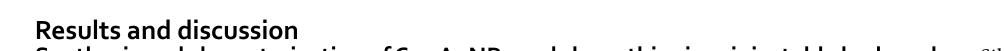
Figure 2. Characterization of Cur-AgNPs and shear-thinning properties of the composite GG/Cur-AgNPs self-healing hydrogel. ( a ) UV–Vis spectrum of Cur-AgNPs. ( b ) TEM image of Cur-AgNPs. ( c ) the average diameter of Cur-AgNPs is 18.24 ± 4.20 nm (n = 75) from TEM. ( d ) Viscosity of the hydrogel composite as a function of shear rate. The hydrogel shows shear thinning which is a favorable property for injectability. e , The concentration of silver ions (Ag + ) released by ‘high’ (1000 μg/mL) and ‘standard’ (500 μg/mL) concentrations of Cur-AgNPs, and for the same concentrations of Cur-AgNPs encapsulated in the GG